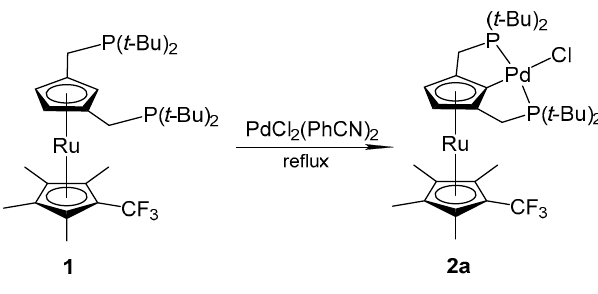
Scheme 2. Cyclopalladation reaction.